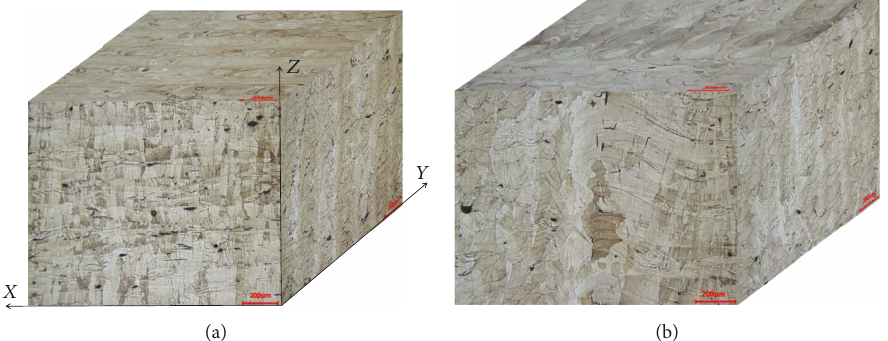
Figure 16: Representative optical micrographs of the SLM 316L SS on the three orthogonal planes showing the X-Y, Y-Z, and X-Z views of (a) sample 1 and (b) sample 2.